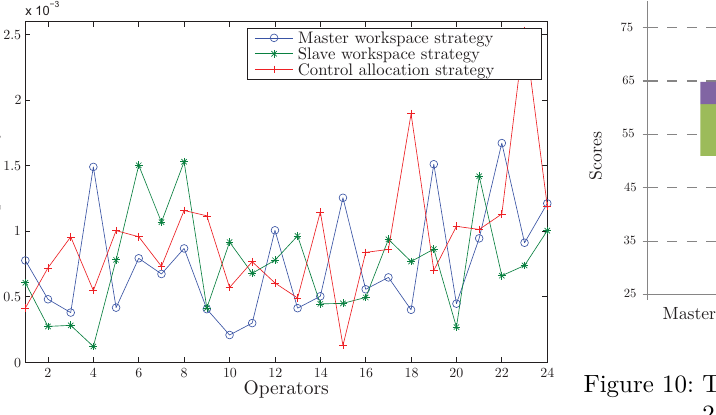
Figure 8: The manipulability in three strategy of 24 inexperienced operators